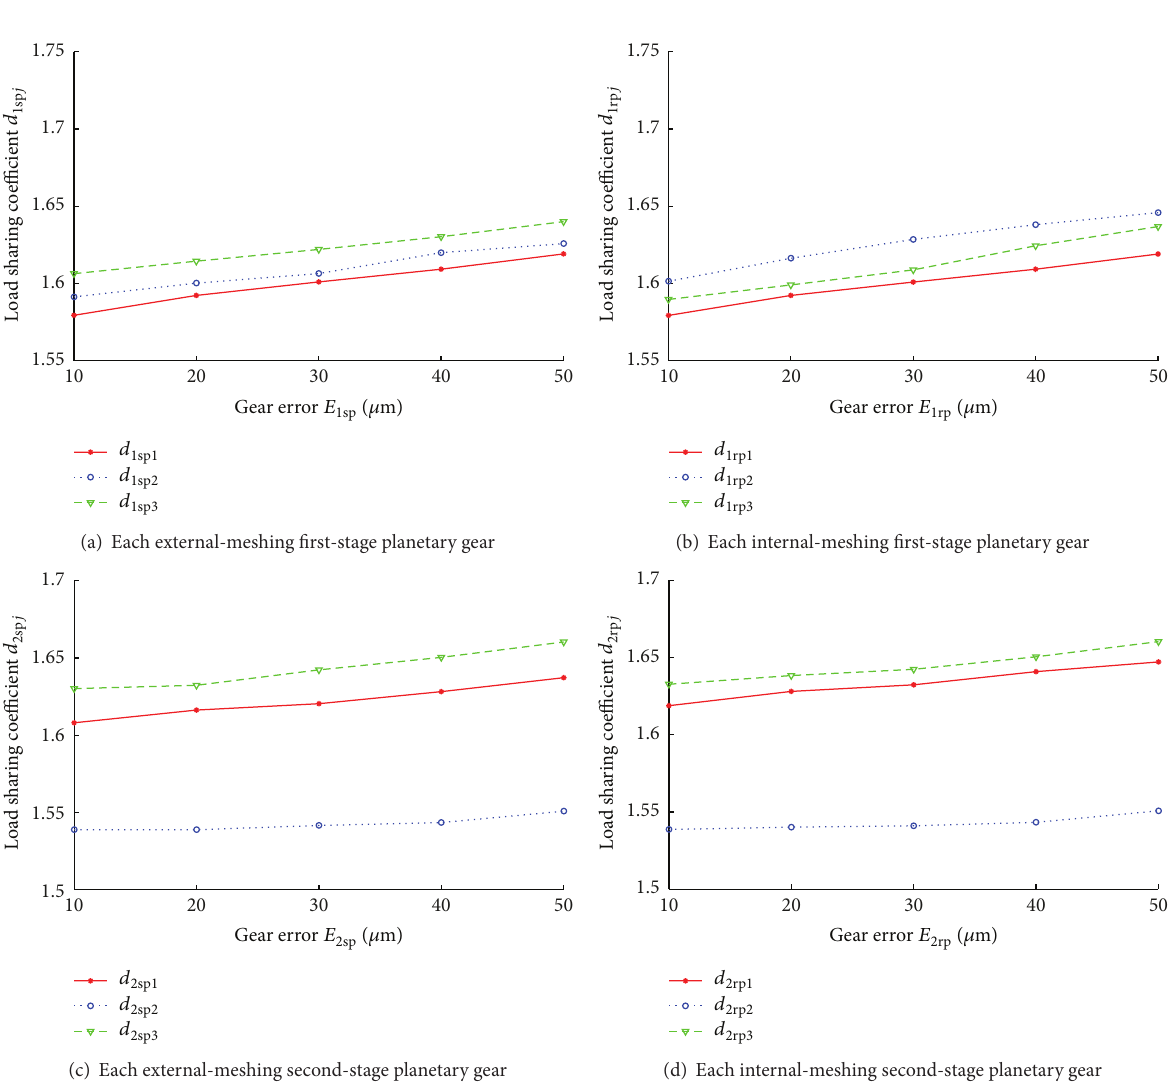
Figure 6: Load-sharing coefficient curves of each planetary gear with different mesh